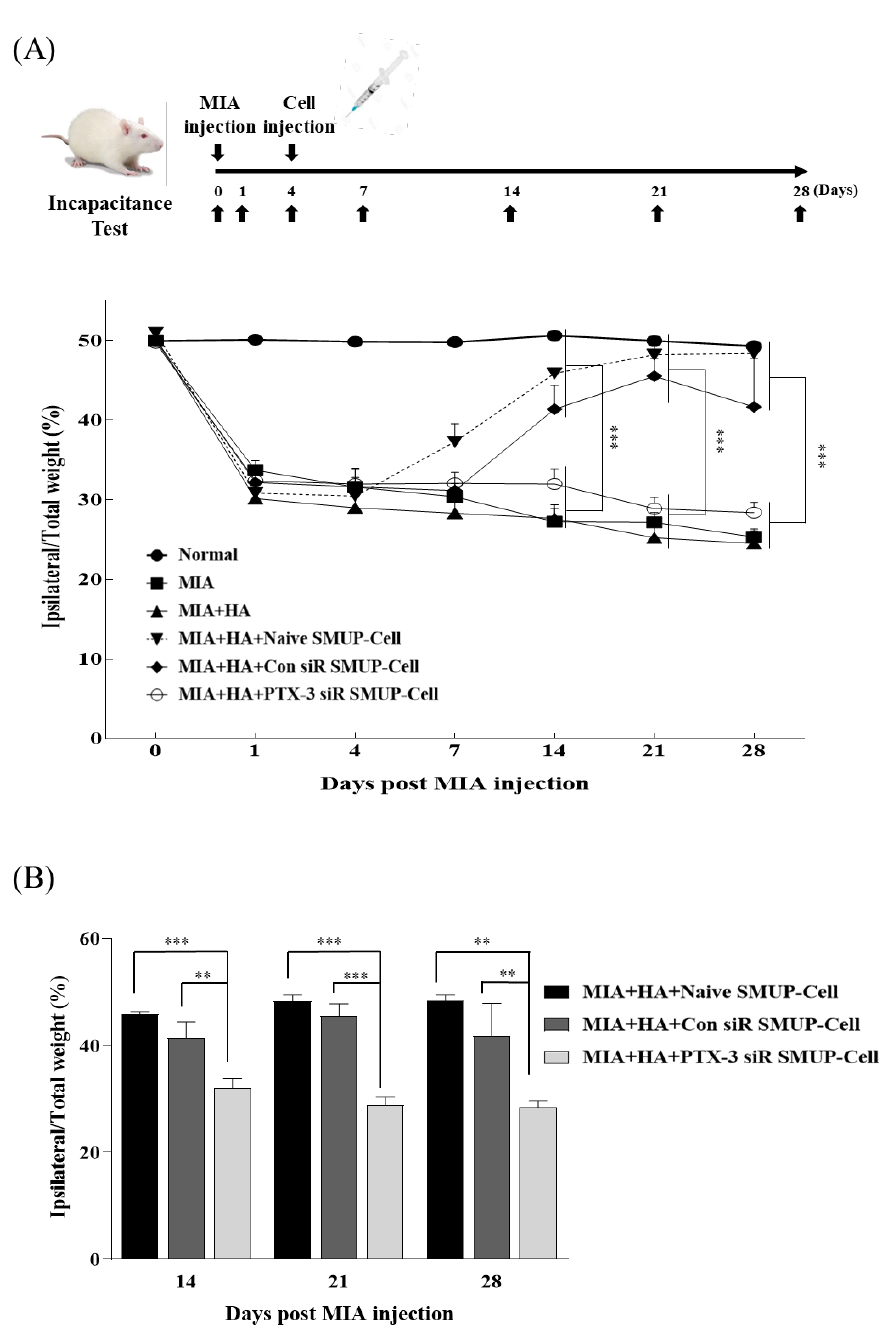
Figure 6. Effect of PTX-3 secreted by SMUP-Cells on pain in the MIA-induced OA rat model. The efficiency of siRNA transfection of SMUP-Cells with scrambled-siRNA (Con siRNA) or PTX-3 siRNA for 24 h. ( A ) Changes in body weight distribution between the hind limbs were calculated as ((weight borne on ipsilateral paw / sum of the weight borne on the ipsilateral and contralateral paws) × 100) and evaluated on days 0, 1, 4, 7, 14, 21, and 28 after the injection of 2 mg MIA. In all groups, HA and the respective cells were IA administered into OA rat knees at 4 days after MIA injection. ( B ) Analysis of body weight distribution in the SMUP-Cell treated OA rat knee at 14, 21, and 28d after MIA injection. Error bars represent mean ± SEM (N = 6 per group). ** p < 0.01, *** p < 0.001. HA, hyaluronic acid; MIA, monosodium iodoacetate .